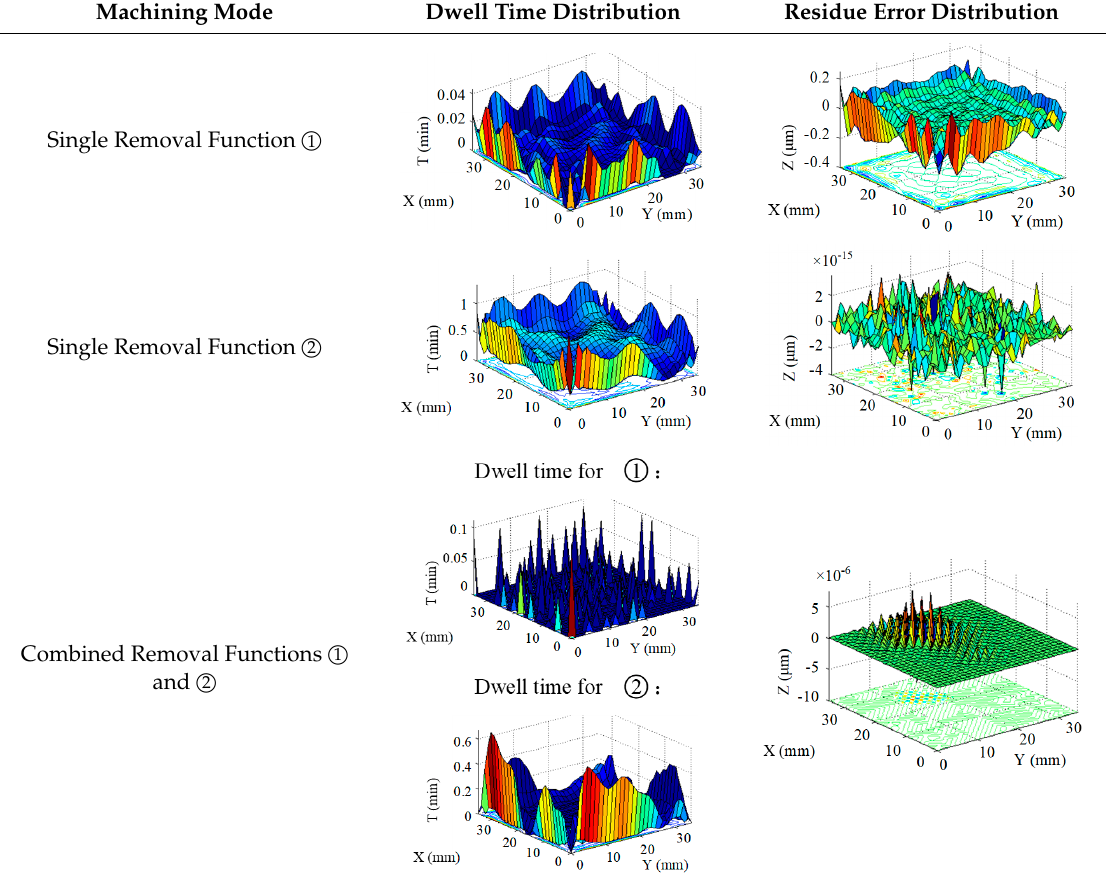
Figure 7. CPP surface for simulation analysis. Table 3. Simulation results of dwell time and residue error distribution.